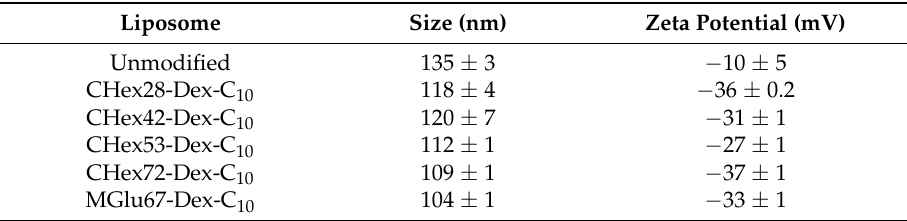
Table 4. Characteristics of